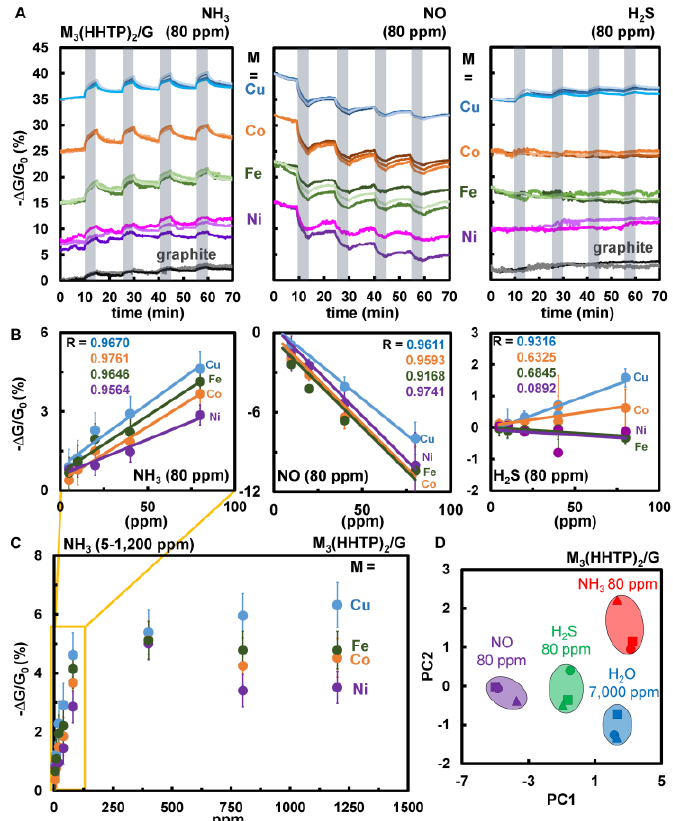
Figure 3. Sensing performance of M 3 HHTP 2 /graphite blends as chemiresistors when exposed to gaseous analytes, and statistical analysis of sensing response. ( A ) Representative sensing traces showing the change in conductance −ΔG/G 0 (%) over time (min) for the M 3 HHTP 2 /graphite blends (Fe 3 HHTP 2 = green, Co 3 HHTP 2 = orange, Ni 3 HHTP 2 = purple, Cu 3 HHTP 2 = blue). The blends were abraded on paper devices between gold electrodes, then exposed to three different gases (80 ppm) diluted with N 2 at room temperature. ( B ) Concentration dependence plots of sensing response of the M 3 HHTP 2 /graphite blends to NH 3 , NO and H 2 S (5–80 ppm). The error bars represent the standard deviation from the average. ( C ) Sensing performance of M 3 HHTP 2 /graphite array towards varying concentrations of NH 3 (1200, 800, 80, 40, 20, 10, 5 ppm) diluted with N 2 . Each concentration was dosed for five minutes, followed by 10-min recovery. A linear increase in response to NH 3 is observed through 80 ppm exposure, with a saturation limit occurring higher that 80 ppm. Subsequent exposures to NH 3 at concentrations higher than 80 ppm show only a very small increase in response. ( D ) Principal component analysis of the data presented in Figure 3A demonstrates the ability of the array to distinguish between 80 ppm NH 3 , H 2 S, NO, and 7000 ppm H 2 O.